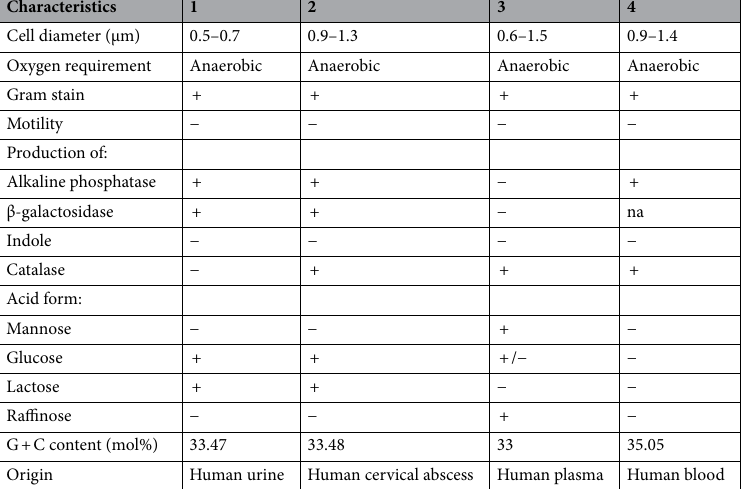
(Fig. 4). It was composed of 10 scaffolds (11 contigs). Of the 2077 predicted genes, 1952 were protein-coding genes and 61 were RNAs (4 genes are 5S rRNA, 3 genes are 16S rRNA, 5 genes are 23S rRNA, 46 genes are tRNA genes) 64 were pseudo genes.